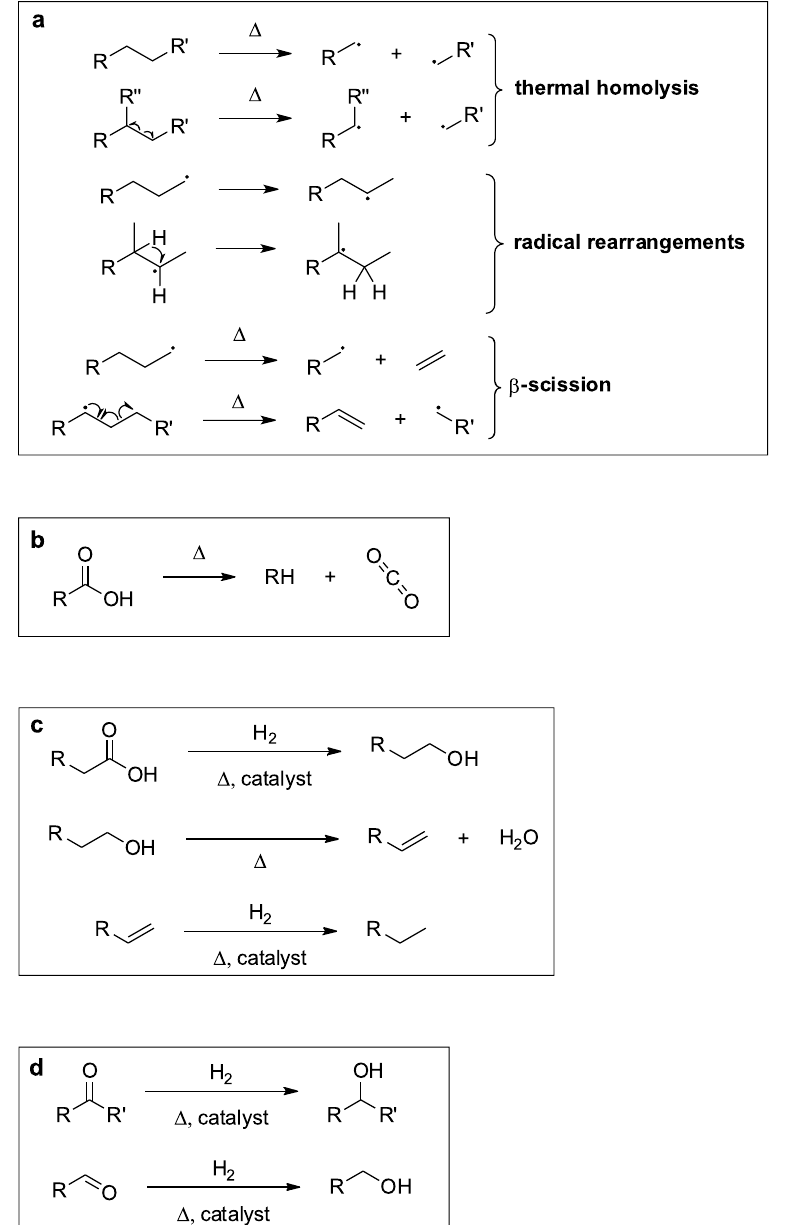
Figure 8. Main chemical processes during formation of equilibrium fluids. ( a ) initial thermal formation of radical species from higher hydrocarbons in homolysis, rearrangement, their further rearrangement and β -scission reactions; ( b ) thermal decarboxylation of carboxylic acids; ( c ) processes involving carboxyl acids; ( d ) hydrogen reduction of carbonyl